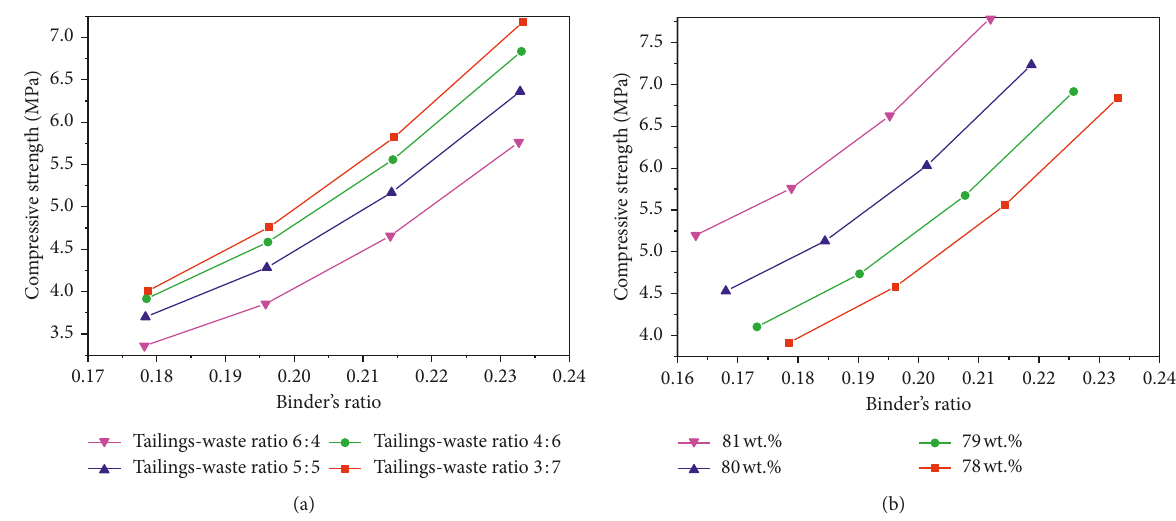
Figure 5: Relationship between UCS and binder content for CPB samples. (a) Concentration 78wt.%. (b) Tailings-waste ratio 4: